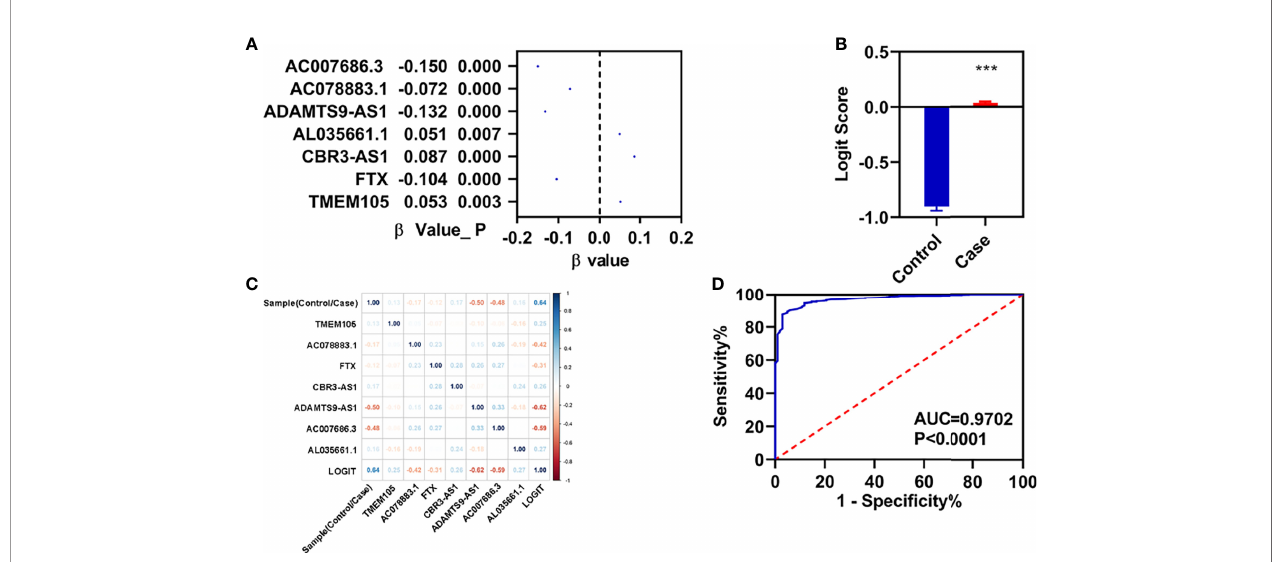
FIGURE 6 | Construction of diagnosis model. (A) b -value of these seven FI-DELs analyzed by stepwise logistic regression. (B) Diagnosis values between normal and patients with breast in fi ltrating duct and lobular carcinoma. (C) Correlation analyses of these seven FI-DELs with diagnosis values. (D) ROC curves of the diagnostic model. ***p < 0.001.